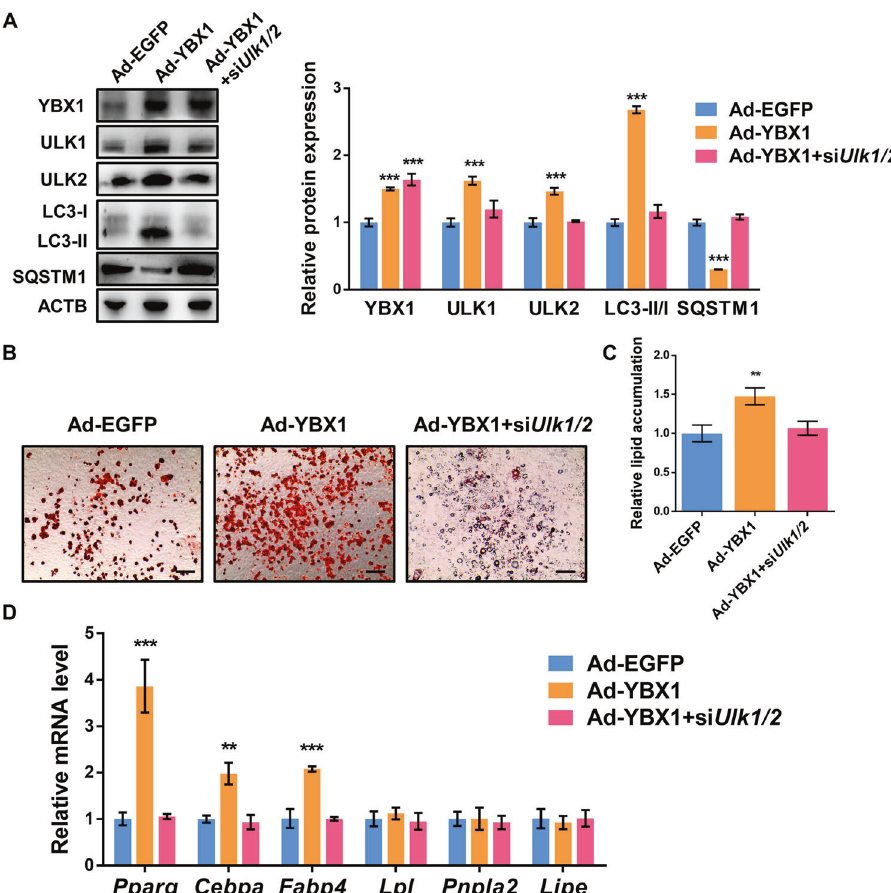
Fig. 4 YBX1 regulates autophagy and adipogenesis by inhibiting both ULK1 and ULK2. A Western blot analysis of YBX1, ULK1, ULK2, LC3 and SQSTM1 in vector and YBX1-overexpressing cells transfected with or without Ulk1 / 2 siRNA. B Oil Red O staining of vector and YBX1- overexpressing cells transfected with or without Ulk1 / 2 siRNA on day 6 of adipogenesis. C Relative lipid accumulation was quanti fi ed with a microplate spectrophotometer at 500 nm. D qPCR analysis of Pparg , Fabp4 , Cebpa, Lpl, Pnpla2 and Lipe expression in vector and YBX1- overexpressing cells transfected with or without Ulk1 / 2 siRNA. The data were presented as the mean ± SD of triplicate tests. ** P < 0.01, *** P < 0.001 compared to control